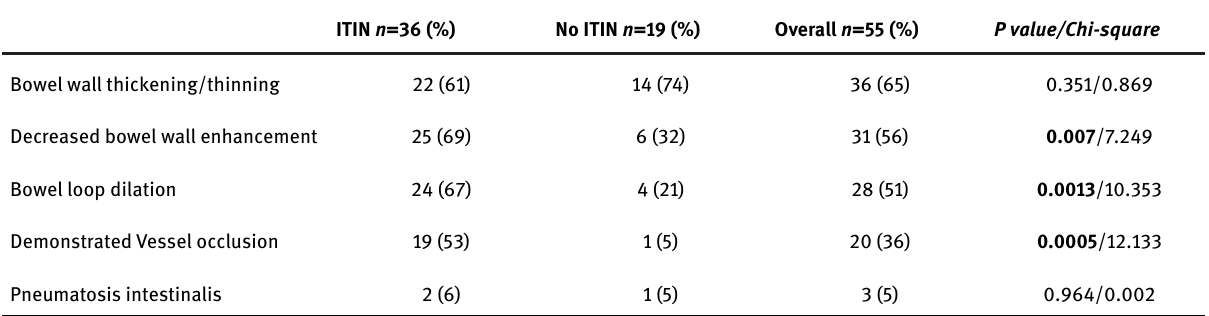
Table 2: Overall CT signs univariate analysis